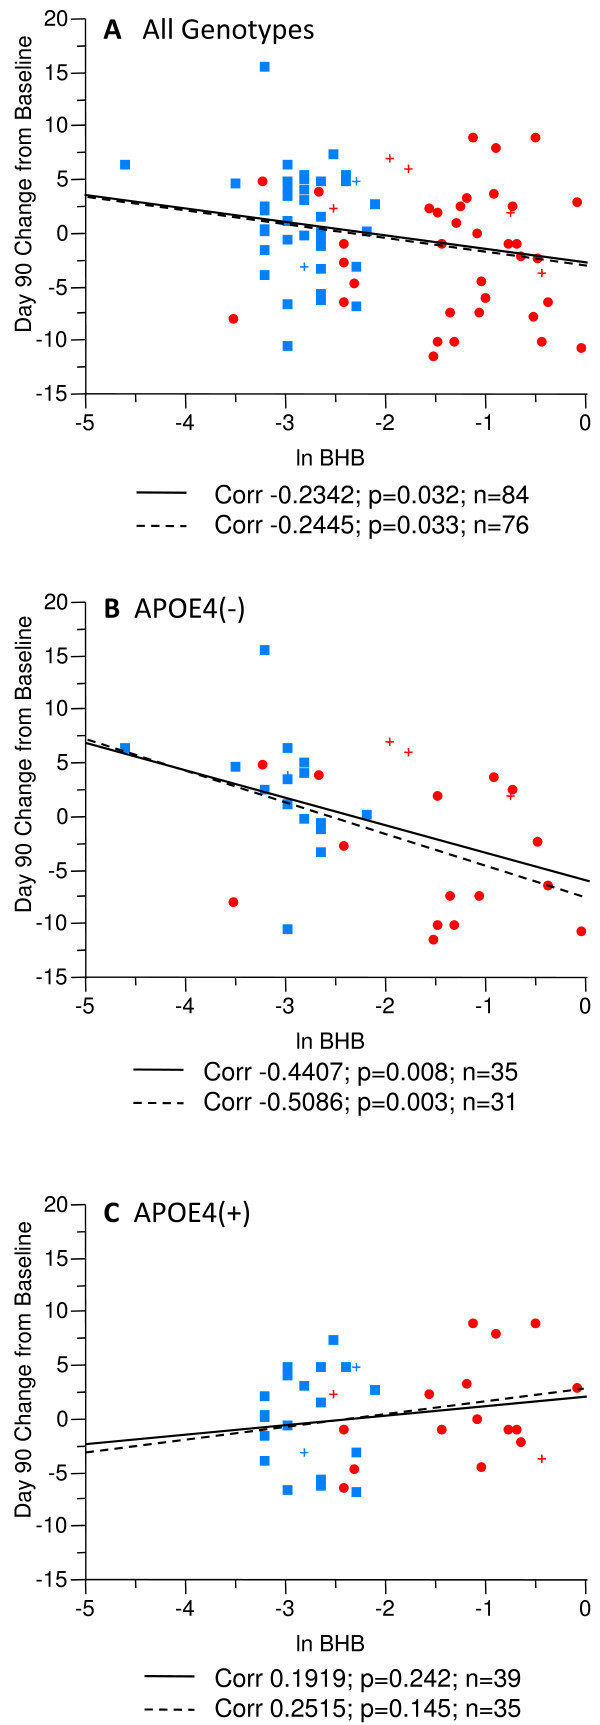
Linear fit of change from Baseline at Day 90 in ADAS-Cog score and log transformed post-dose serum BHB levels in the per protocol population stratified by APOE4 carriage status. Red symbols represent subjects taking AC-1202. Blue symbols represent subjects taking Placebo. Circles and squares indicate dosage compliant subjects, crosses represent non-compliant subjects. The solid lines represent the linear fit in the per protocol population. The dashed lines represent the linear fit in the dosage compliant sub-population of the per protocol population. A) A significant correlation was found in the per protocol population between serum BHB levels and change in ADAS-Cog on Day 90. B) A significant correlation was found in E4(-) per protocol subjects between serum BHB levels and change in ADAS-Cog on Day 90. C) No significant correlation was found in E4(+) per protocol subjects between serum BHB levels and change in ADAS-Cog on Day 90. In each case the linear fit of the dosage compliant subgroup is very similar to the overall per protocol population.